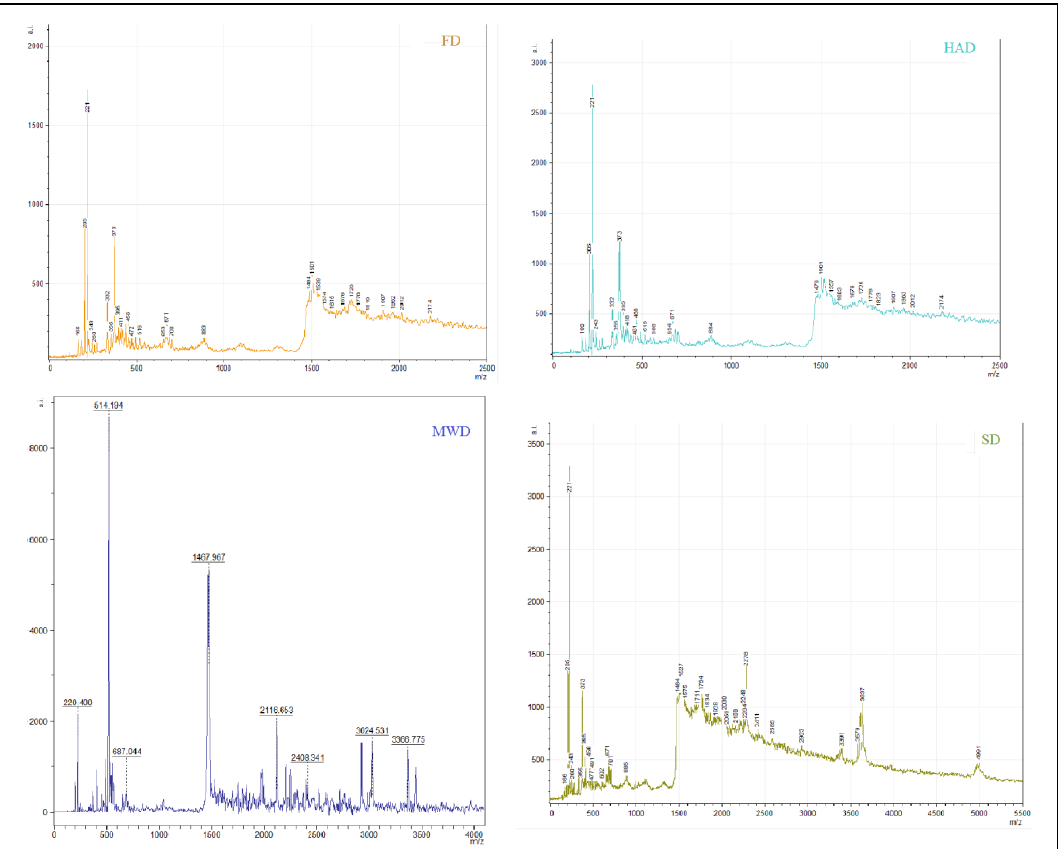
Figure 5. Data of the MALDI-TOF mass spectrometry of dry fruiting bodies Pleurotus ostreatus after in vitro digestion. FD—freeze drying; HAD—hot air drying; MWD—microwave drying; SD—sun drying.